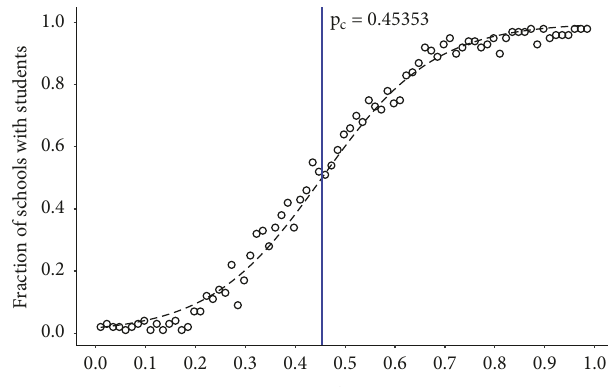
Figure 1: The fraction of schools with students for different values of 𝑝 𝑎 , under the individual expectations model. The segmented line corresponds to the fit with (1 + 𝑒 −𝛽(𝑝 𝑎 −𝑝 𝑐 ) ) −1 with 𝛽 = 8.9 and 𝑝 𝑐 = 0.45 .